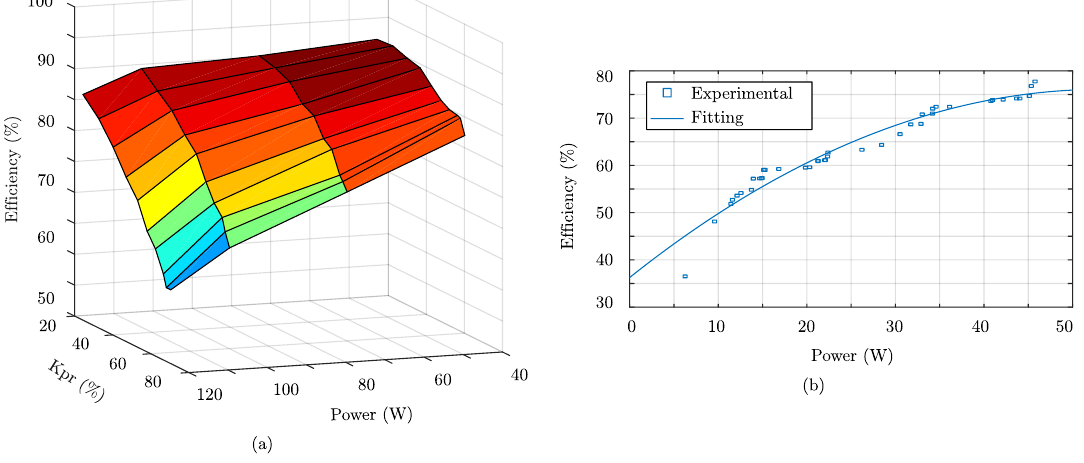
Figure 8. Curve of experimental efficiency: ( a ) Total power conversion system. ( b ) Isolated DC-DC converter in the Step-Up Flyback based